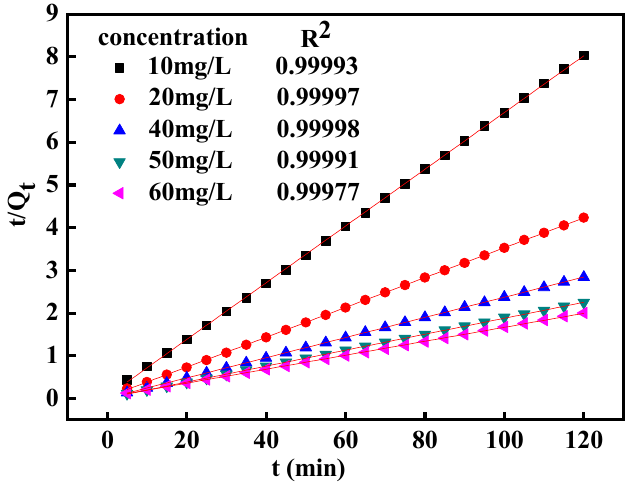
Figure 8. The linear plots of pseudo-second-order kinetic models.